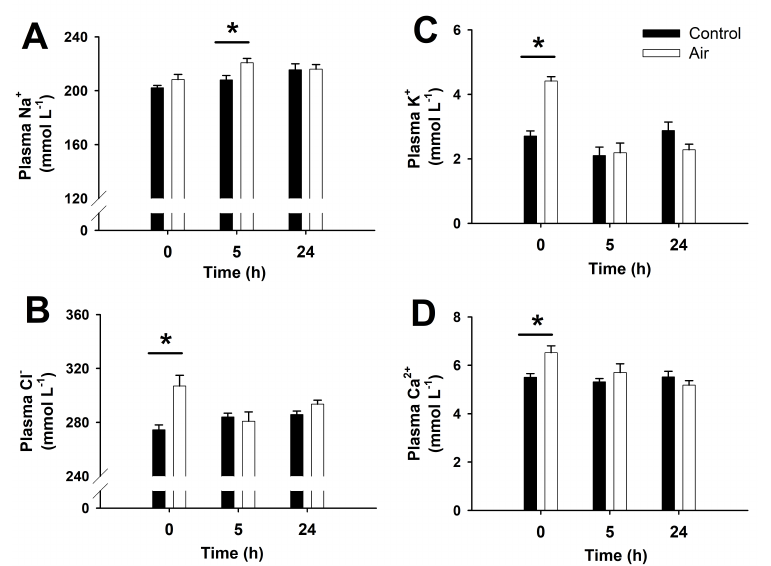
Figure 2. Plasma sodium ( A ), chloride ( B ), potassium ( C ), and calcium ( D ) in S. canicula after air exposure and recovery. Data are expressed as mean ± s.e.m. Asterisks (*) indicate significant differences between both groups at each time ( p < 0.05, n = 7–8).